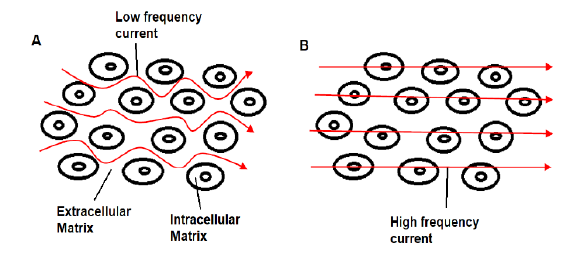
Figure 1. Flow of electrical current through biological tissue: A) At lower frequencies, current flows between the cells and through the extracellular fluid, B) At high frequencies, current penetrates the cell membranes and flows through intracellular and extracellular